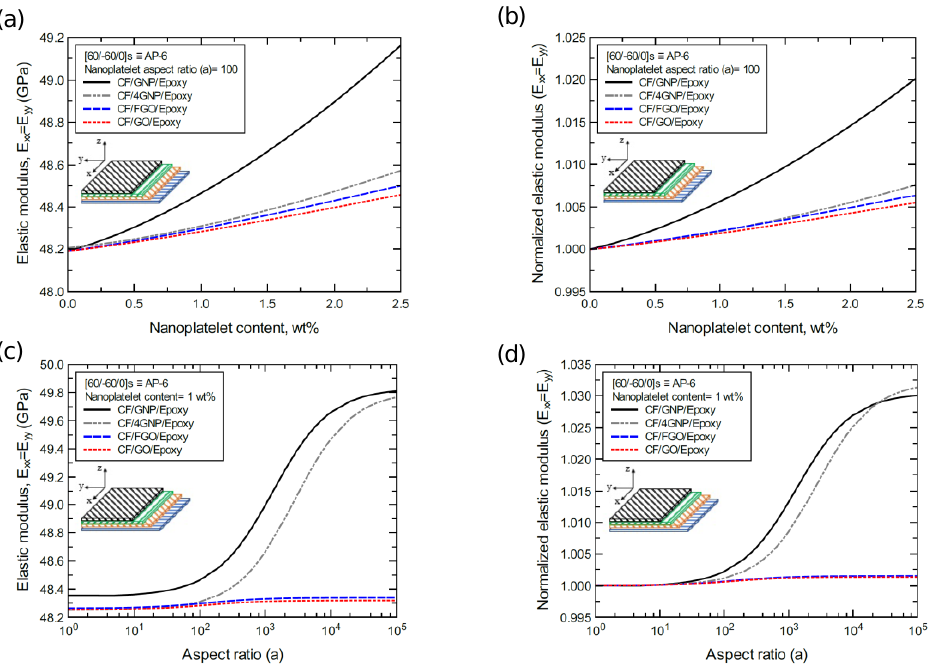
Figure 20. Comparison of the predicted in-plane elastic modulus (E xx = E yy ) for a [60/-60/0]s (AP-6)-laminated composite plate based on the nanoplatelet type, content, and aspect ratio; ( a ) predicted E xx for various nanoplatelet contents at 100 aspect ratio, and the normalized response is shown in ( b ); ( c ) predicted E xx for various aspect ratio values at 1.0 wt% nanoplatelet content, and the normalized response is shown in ( d ). The volume fraction of CF is 56%.